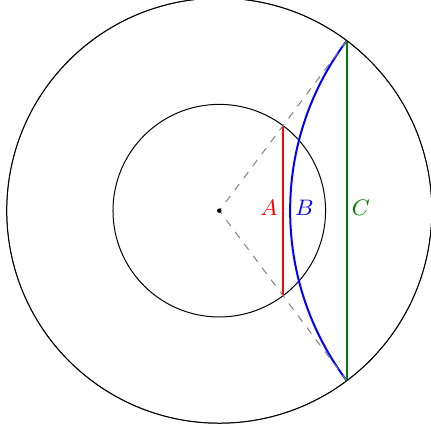
Figure 5. Difference between the Beltrami-Klein disk and the undistorted camera image for α = 1 . The line A gets distorted to circle B which is close to A near the origin. This ensures that the distorted and undistorted images almost agree at the image center. Circle B in the Poincar´e disk corresponds to line C in the Beltrami-Klein disk which both intersect at the disk border. Line C is twice as long and twice as far away from the origin as line A . Instead of being close at near the origin, C shares other properties with B , e.g. the polar of C with respect to the disk border is the center of the circle B , see Fig. 6.